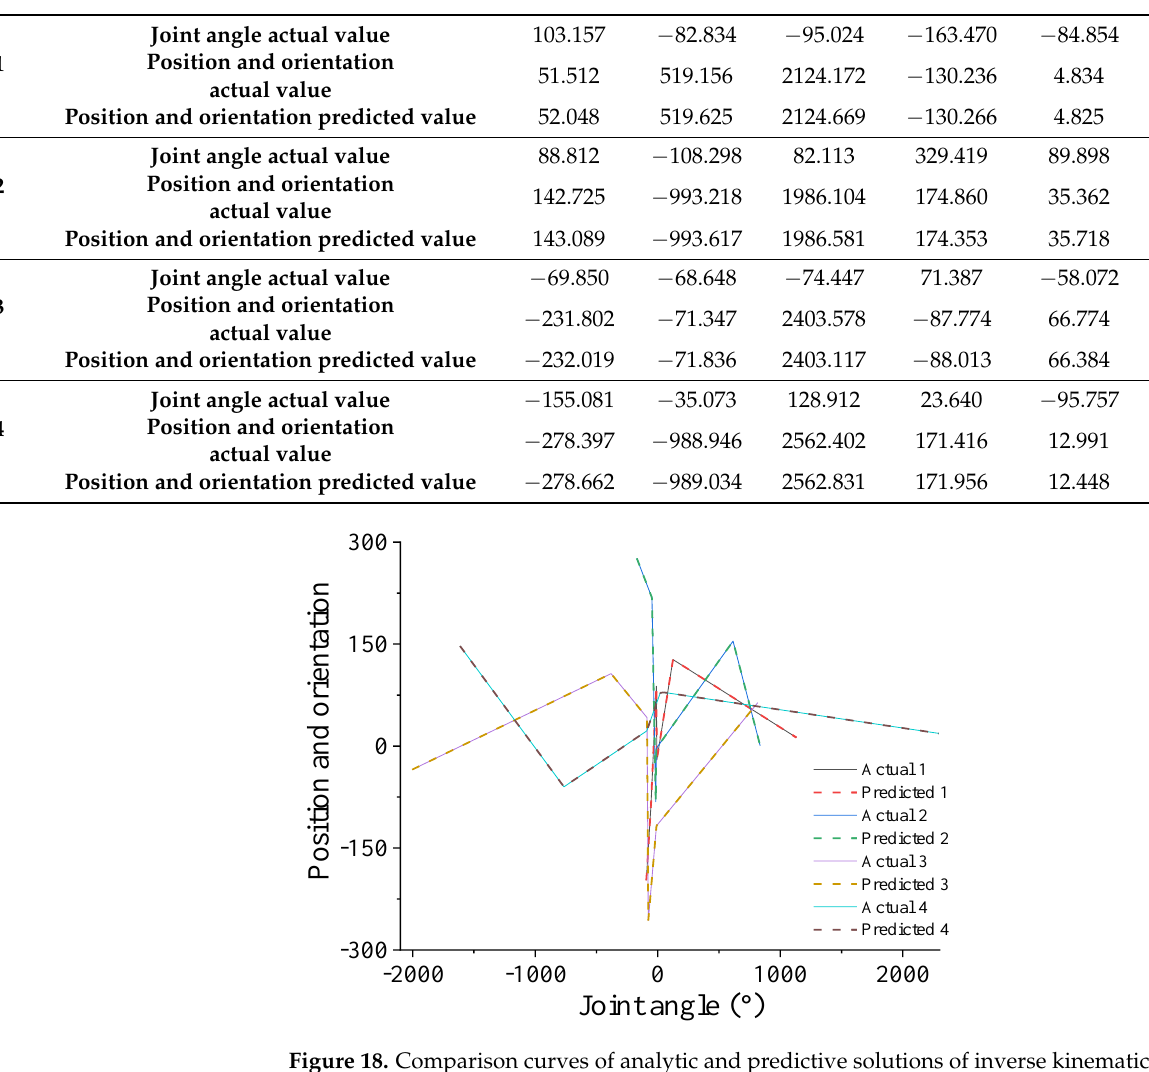
Table 8. Comparison of analytic and predictive solutions of forward kinematics.